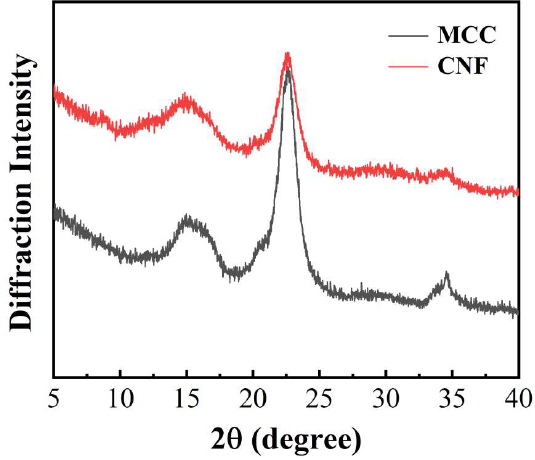
Figure 2. XRD patterns of MCC and CNF.